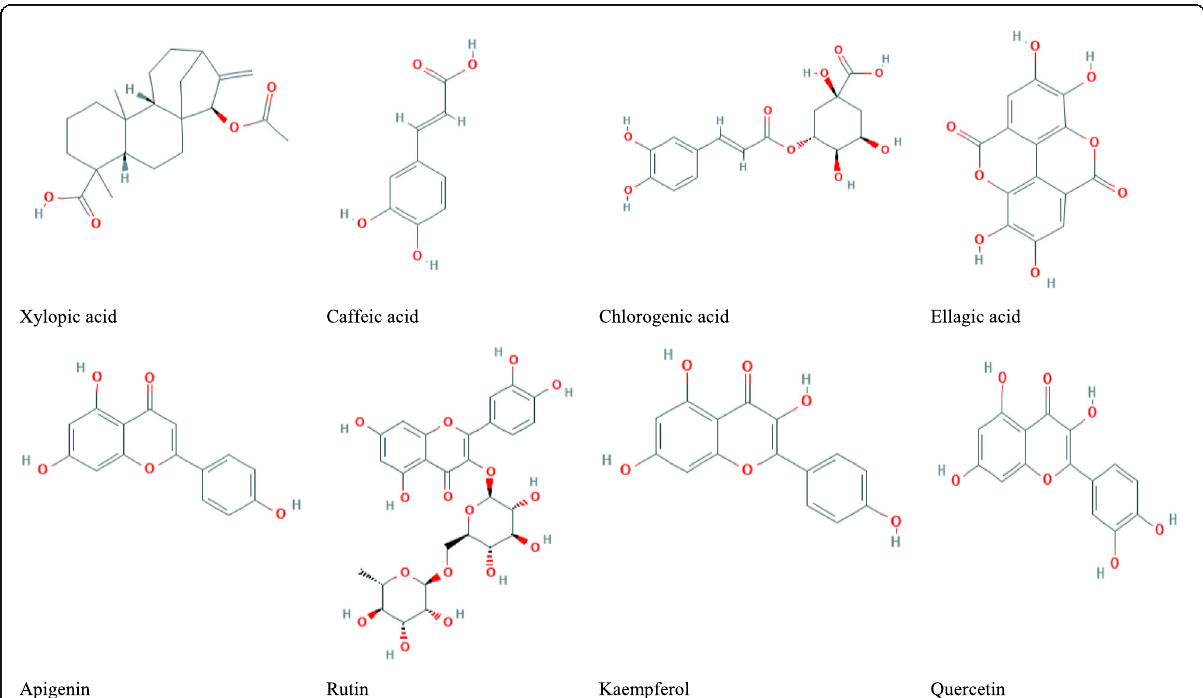
Fig. 2 Depiction of chemical structures of the selected compounds as obtained from the PubChem database